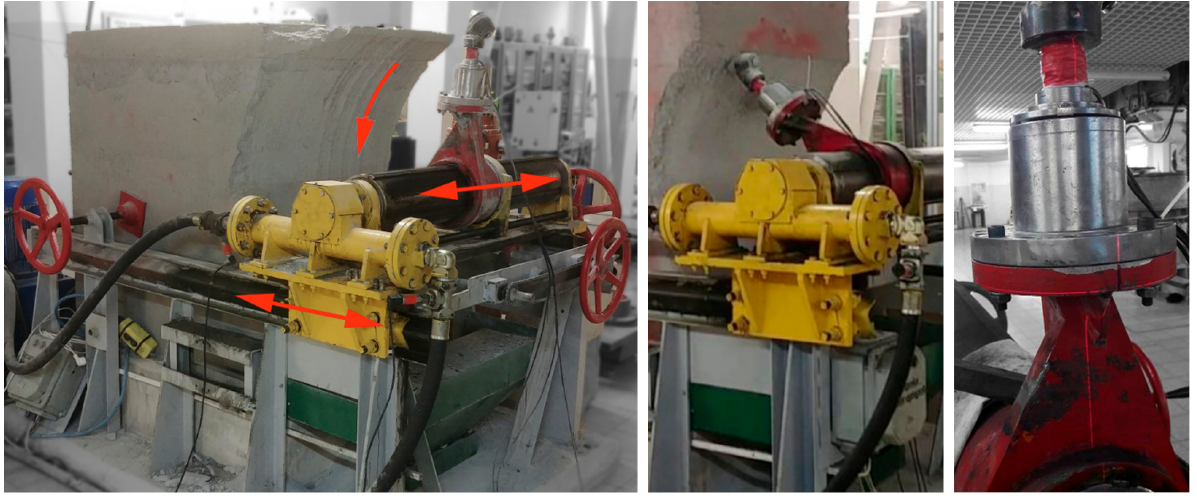
Figure 14. Arm-equipped stand for testing single tools